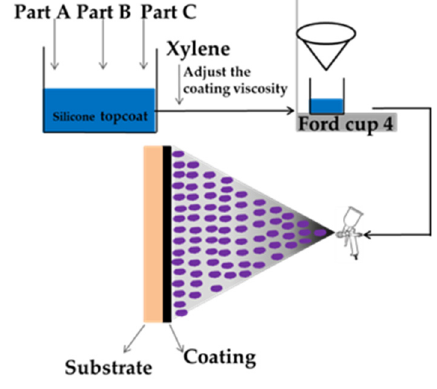
Figure 2. Spraying process of silicone topcoat.